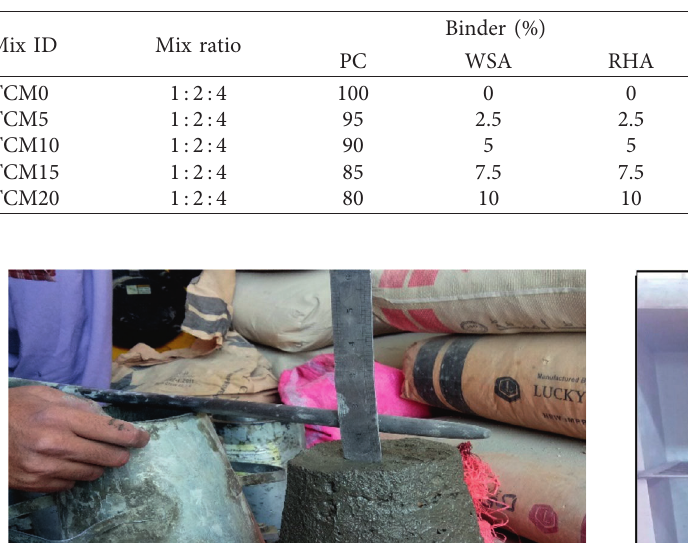
Table 3: Mix proportion of